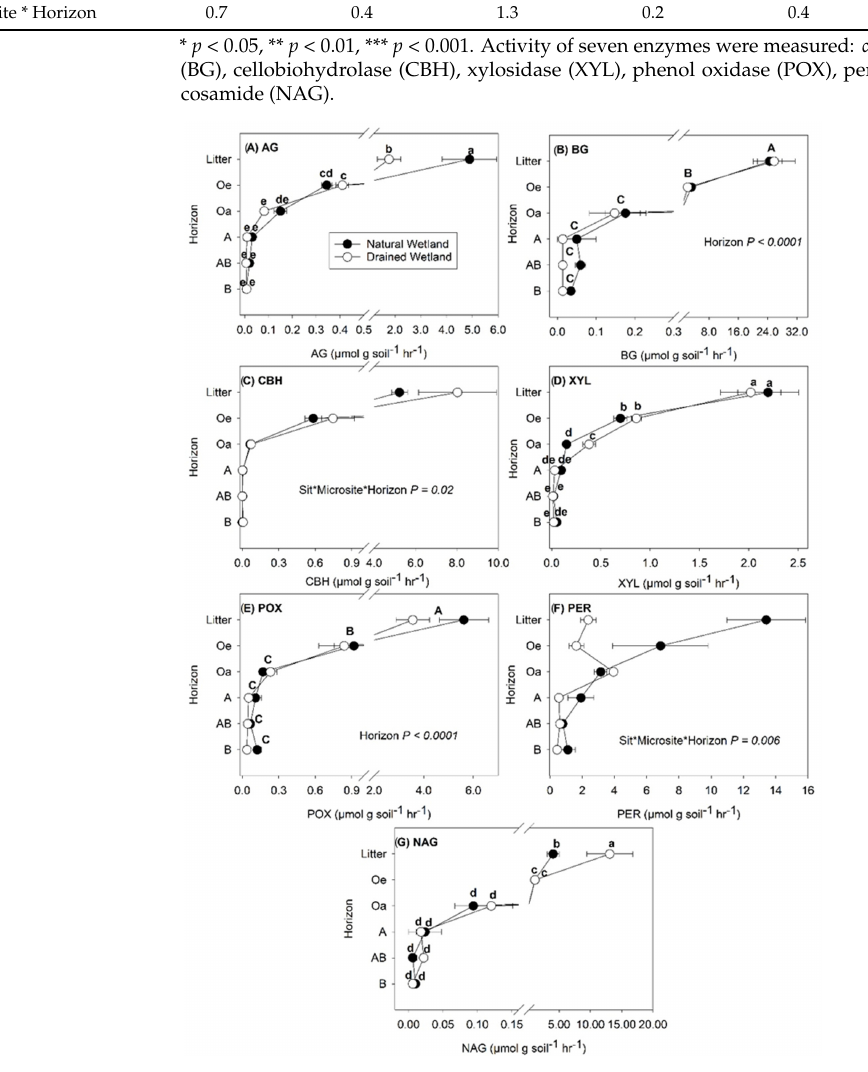
Figure 1. Enzyme activity rates calculated per unit mass of dry soil ( µ mol g soil − 1 h − 1 ) in soils collected from different soil horizons within a natural and managed freshwater forested wet- land. Activity of seven enzymes were measured: ( A ) α -glucosidase (AG), ( B ) β -glucosidase (BG), ( C ) cellobiohydrolase (CBH), ( D ) xylosidase (XYL), ( E ) phenol oxidase (POX), ( F ) peroxidase (PER) and ( G ) N-acetyl glucosamide (NAG). Values are means with standard error ( n = 5) and averaged across microsite, depicting the site by horizon interaction found for most enzymes assayed. Lowercase letters represent significant differences ( p < 0.05) between each site and horizon when a significant site by soil horizon interaction was found. Uppercase letters represent significant differences between soil horizons when a soil horizon main effect only was